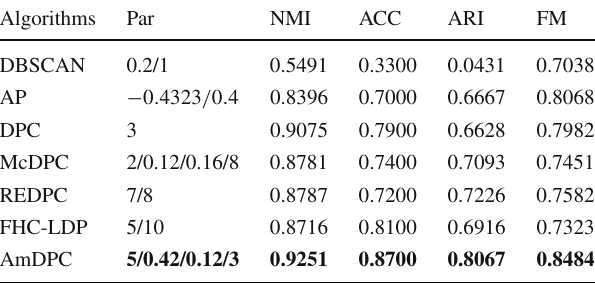
Table 5 Olivetti Face clustering evaluation indexes results